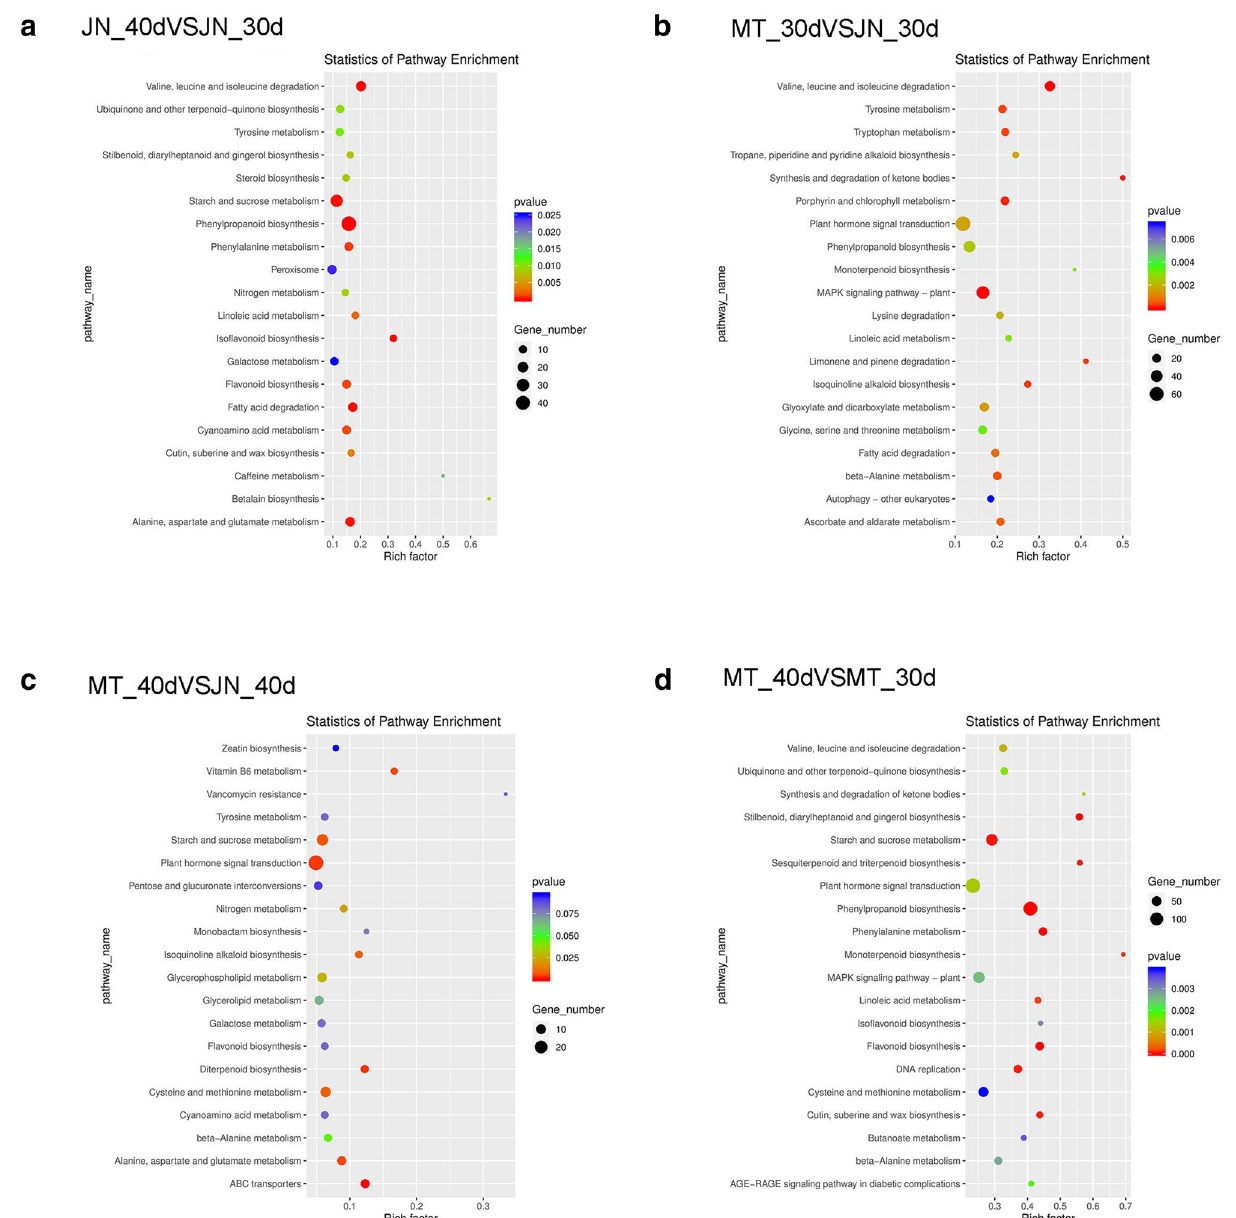
Figure 9. KEGG analysis of target protein-coding genes of differentially expressed lncRNAs in soybean. ( a ) JN_40 versus JN_30, ( b ) MT_30 versus JN_30, ( c ) MT_40 versus JN_40, ( d ) MT_40 versus MT_30. MT_40, MT72 at 40 d after flowering, MT_30, MT72 at 30 d, JN_40, JN18 at 40 d, JN_30, JN18 at 30